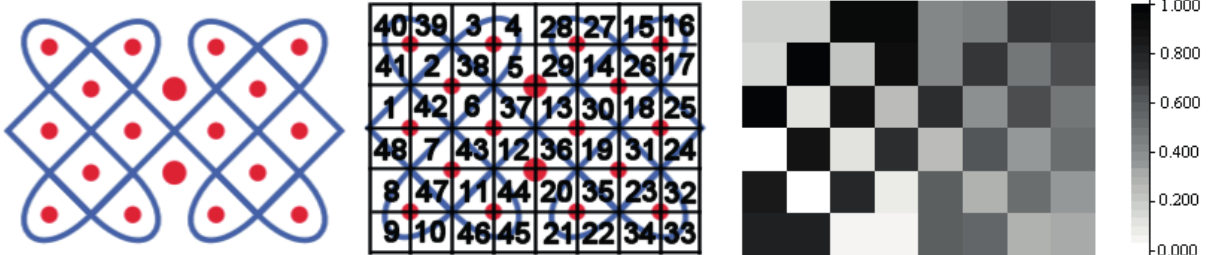
Figure 12. Transforming the Tchokwe lusona representing a nest of doves not into a digital (1010101…) heat map like the one used for comparison purposes, but to a heat map where the values assigned to the squares decline in direct proportion to the number of squares crossed by the monolinear line as it traces its way from the point of origin back to